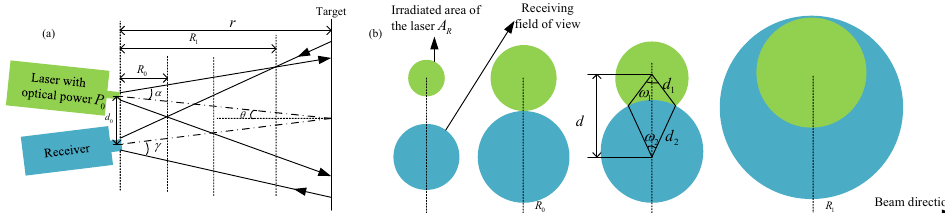
Figure 1. ( a ) Schematic diagram of the backscattering model, ( b ) the variation of the light spot and the receiving field of